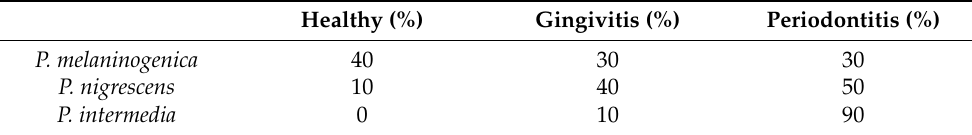
Table 1. Distribution of isolates by species and periodontal diagnosis. Healthy